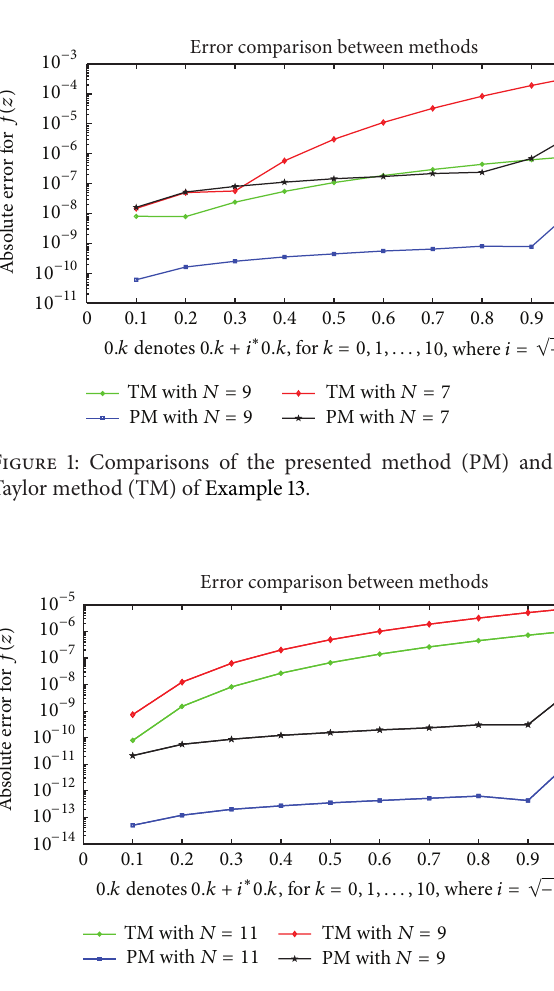
Figure 2: Comparisons of the presented method (PM) and the Taylor method (TM) of Example